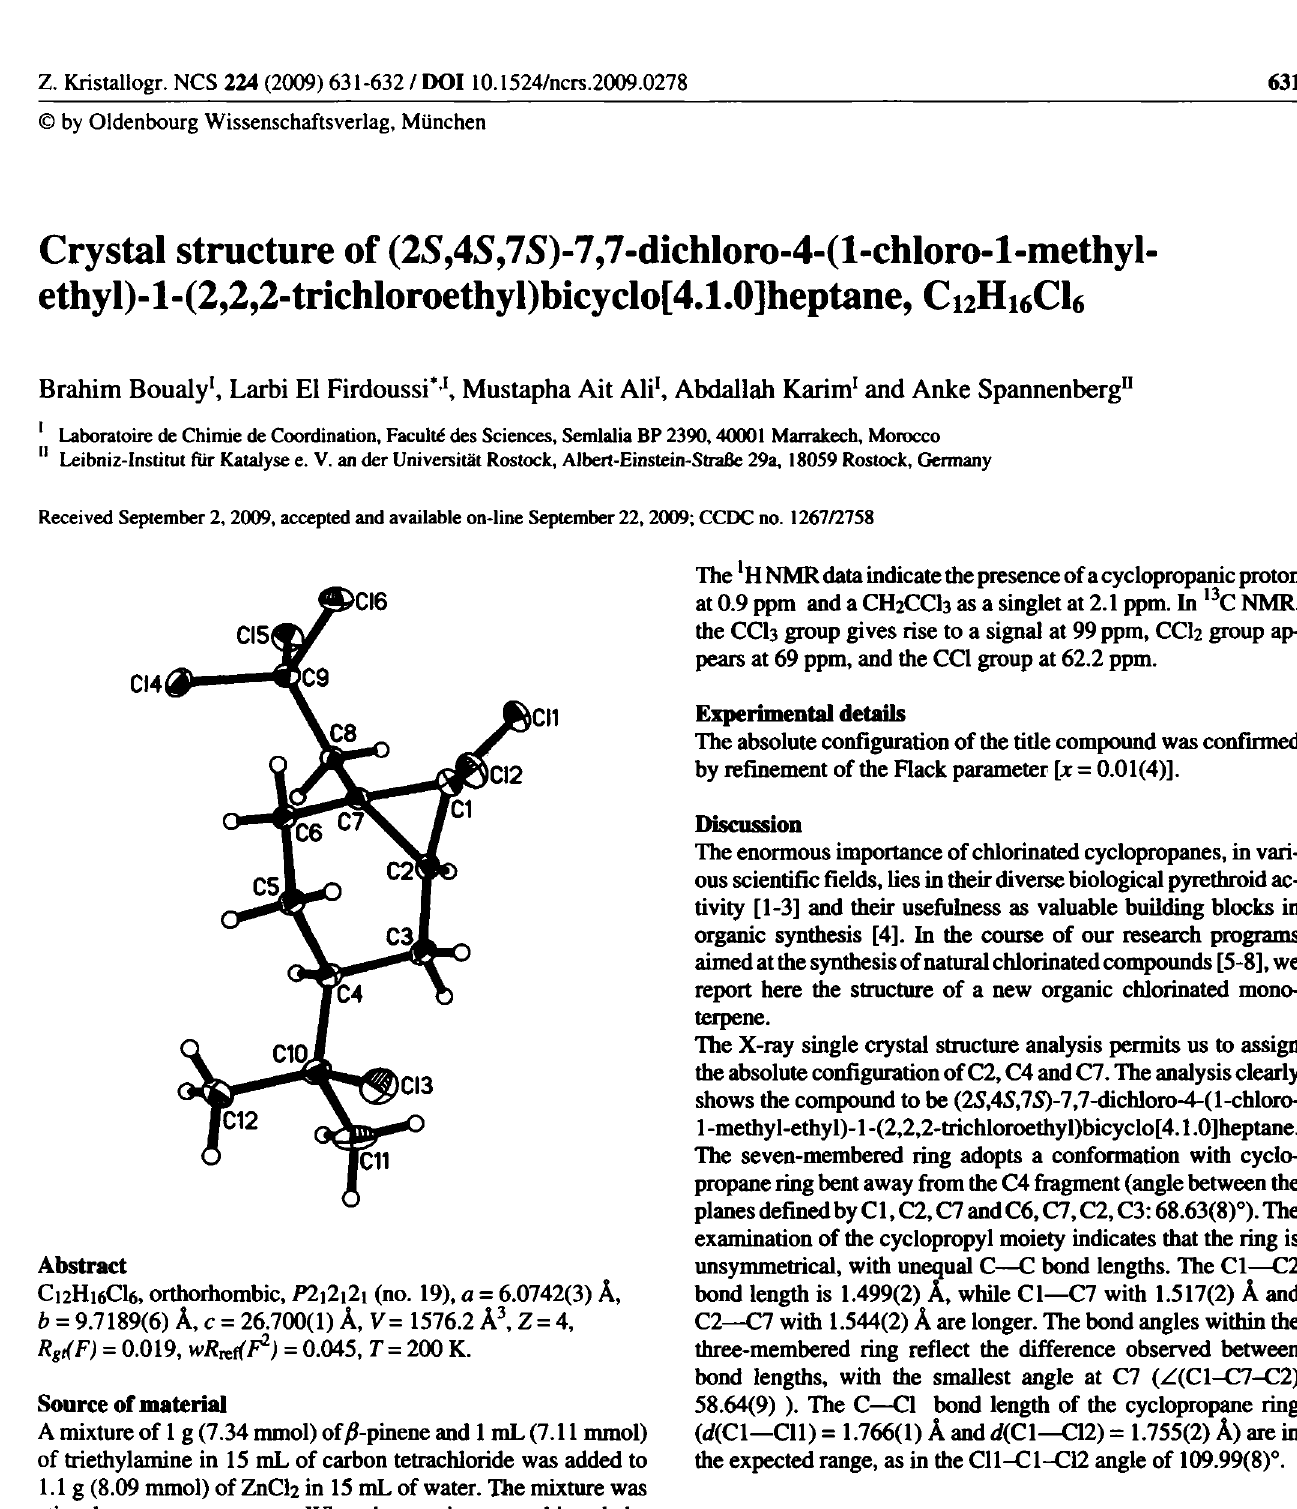
Table 1. Data collection and